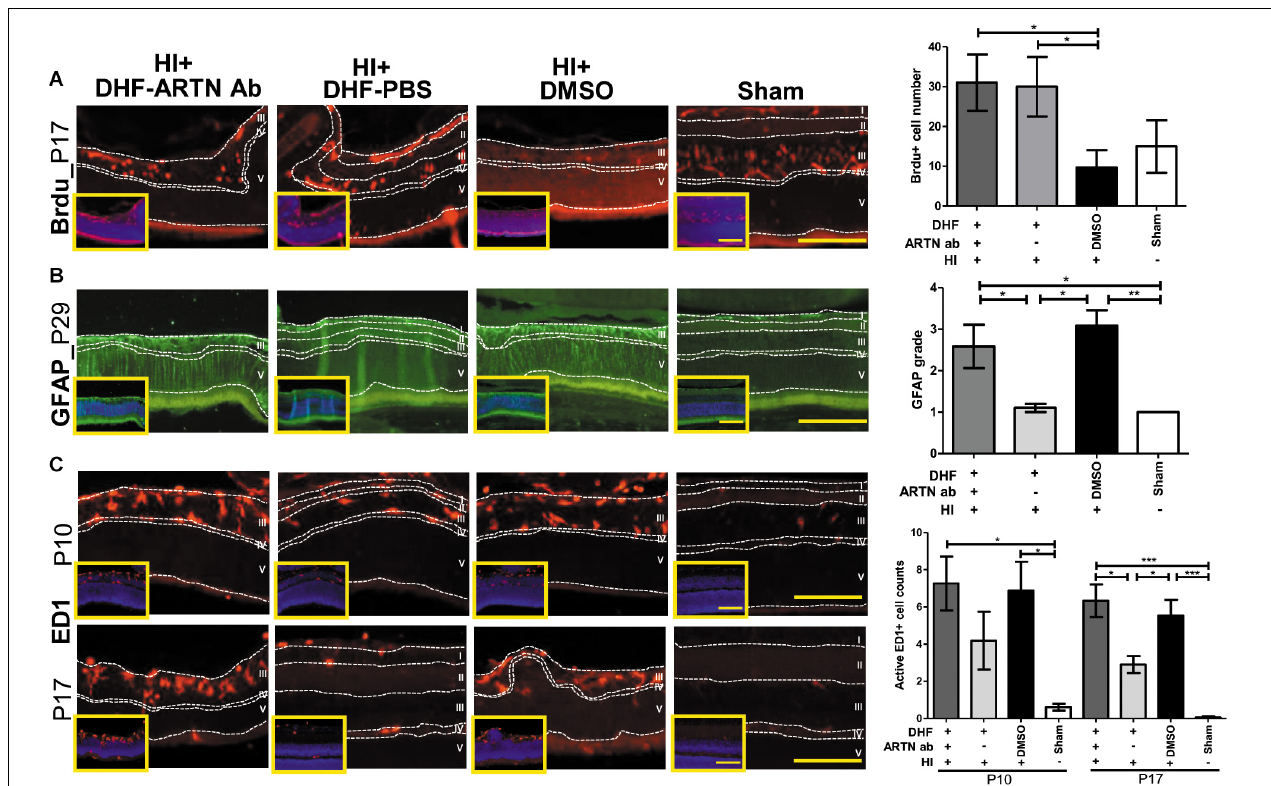
FIGURE 3 | ARTN Antibody blocks the protective effect of systemic DHF treatment in HI-injured retinas by increasing neuroinflammation. (A) At P17, he Brdu + cells localized in the retina ganglia cells (RGC, layer I), inner plexiform layer (IPL, layer II), and inner nuclear layer (INL, layer III) in sham controls. There was almost complete loss of layers I and II but preserved layers IV (outer plexiform layer, OPL) and V (outer nuclear layer, ONL) in DMSO- and DHF-ARTN Ab-treated HI groups in the representative figures. The DMSO-treated HI group had few Brdu + cells in the layer III. The total Brdu + cells was significantly lower in the DMSO-treated HI group as compared to in the DHF-PBS and DHF- ARTN Ab groups after HI. There was no significant difference in the DHF-PBS- and DHF- ARTN Ab-treated HI groups. (B) At P29, GFAP immunostaining was extensive throughout all retinal layers in the DMSO-treated and DHF-ARTN Ab groups after HI. The grades of GFAP immunoreactivity were significantly higher in the DMSO-treated and DHF-ARTN Ab groups than in the DHF-PBS and sham control groups. (C) The ameboid microglial cells (active ED1 + cells) localized in the layers I, II and III after HI at P10. The DMSO- and DHF- ARTN Ab-treated HI groups had prominent ameboid microglial cells mainly in layer III as the layers I and II were lost. The microglial cells were less active in the DHF-PBS-treated HI groups at P17. But the DMSO- and DHF-ARTN Ab-treated HI groups still had prominent ameboid microglial cells in layer III of retina. The group data showed that the active ED1 + cell counts were markedly increased in the DMSO- and DHF-ARTN Ab-treated HI groups as compared with the sham controls at P10 and P17. The DHF-PBS group exhibited significantly decreased active ED1 + cells than the DMSO and DHF-ARTN Ab groups at P17. There was no significant difference between the DMSO- and DHF-ARTN Ab-treated HI groups at P10 and P17. The insets showed the nuclear counterstaining with DAPI (blue). Scale bars: 100 µ m in main figures and insets; n = 4–11 per group in each time point, power = 0.8, * p < 0.05, ** p < 0.01, *** p <